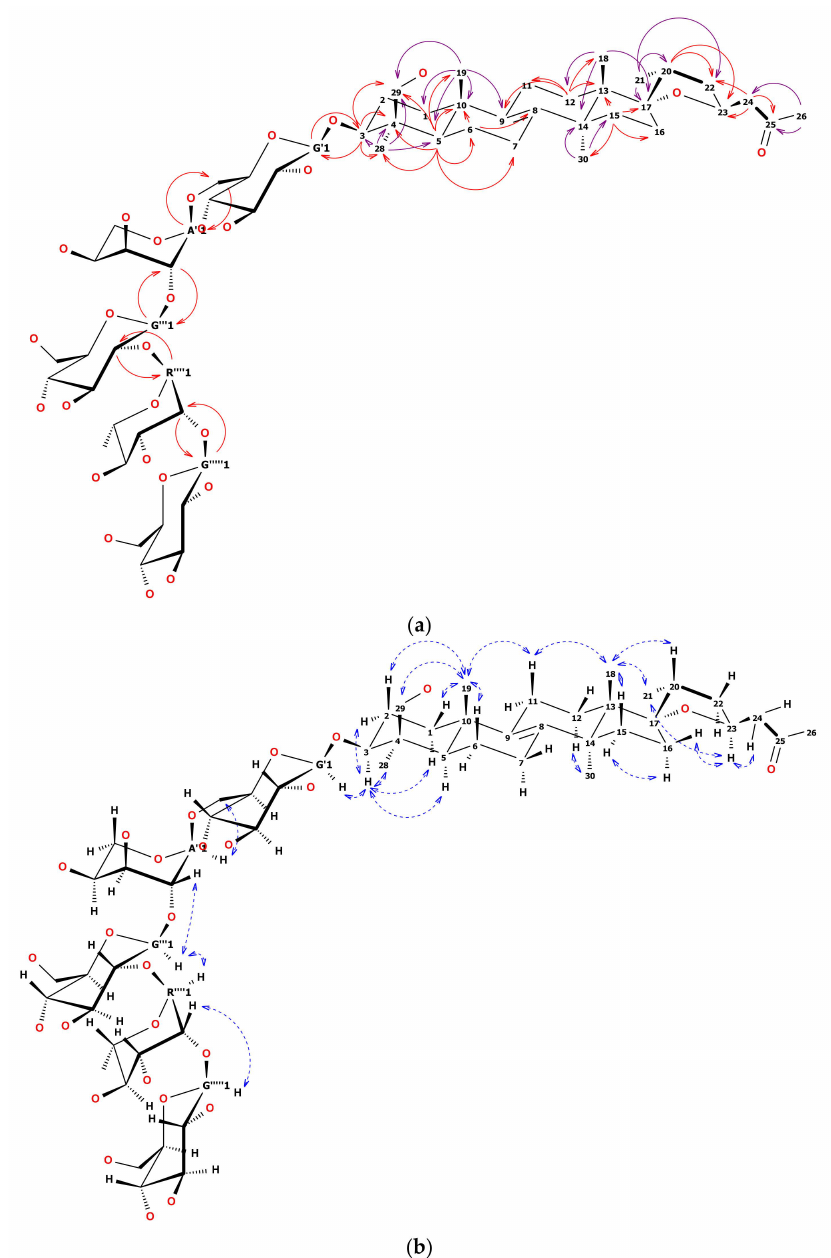
Figure 2. ( a ) Structure of 12 . Solid, one-way arrows represent the key HMBC correlations (violet from methyl groups, red from other hydrogens). ( b ) Structure of 12 . Dashed, blue, two-way arrows